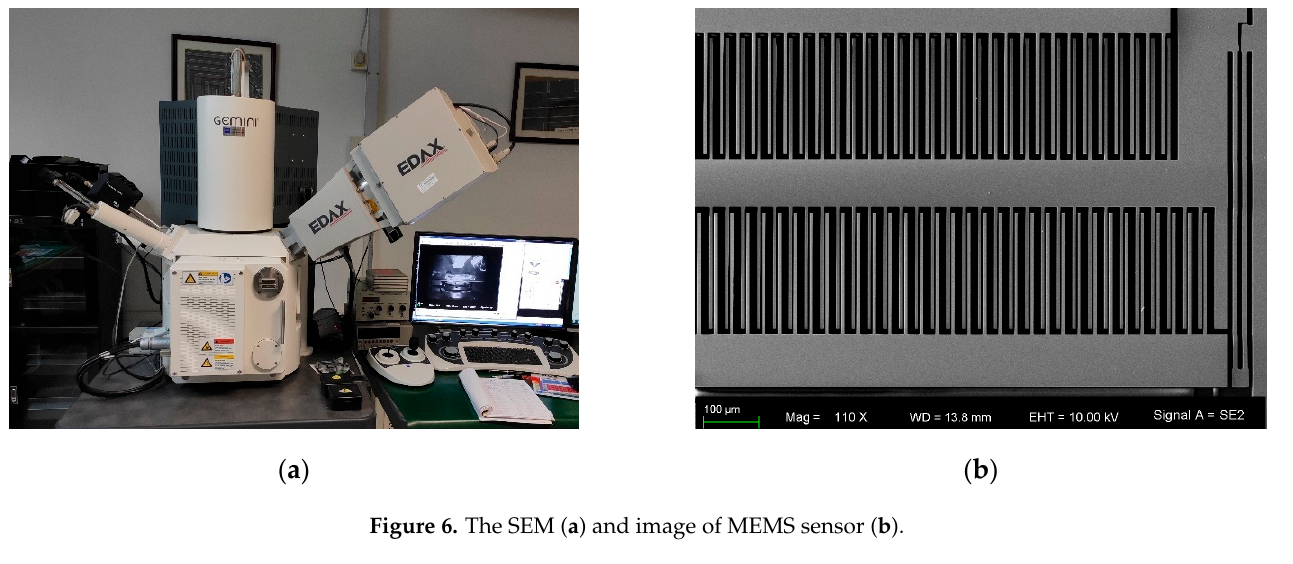
Figure 5. Fabrication steps of MEMS sensor ( a ) RIE on silicon; ( b ) metal patterning on glass; ( c ) anodic bonding; ( d ) silicon wafer thinning; ( e ) deep RIE on silicon. The fabricated sensor is observed using a scanning electron microscope, and the SEM image is shown in Figure 6.